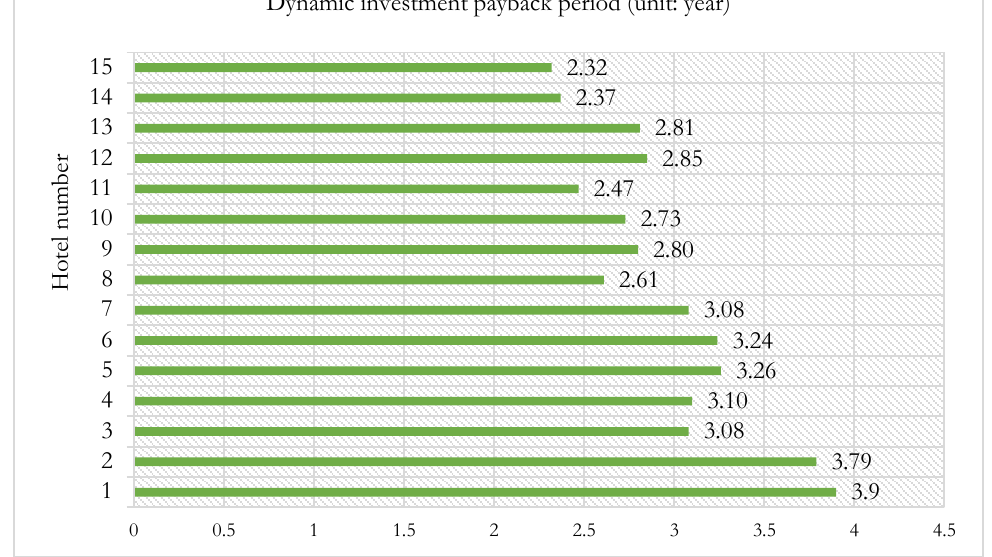
Figure 4. Comparison of dynamic investment payback period.